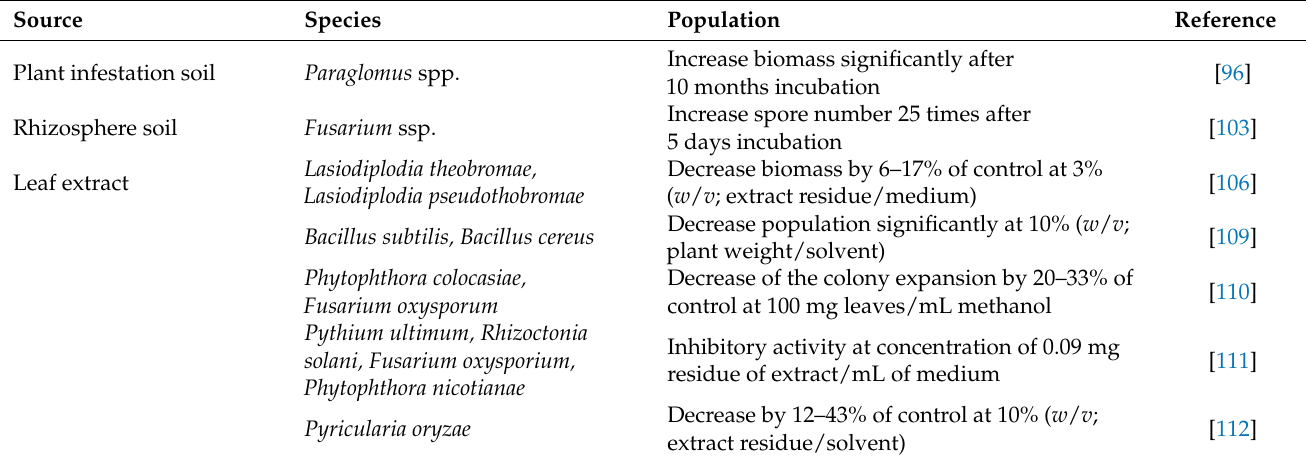
Table 3. Interaction of C. odorata with microbial